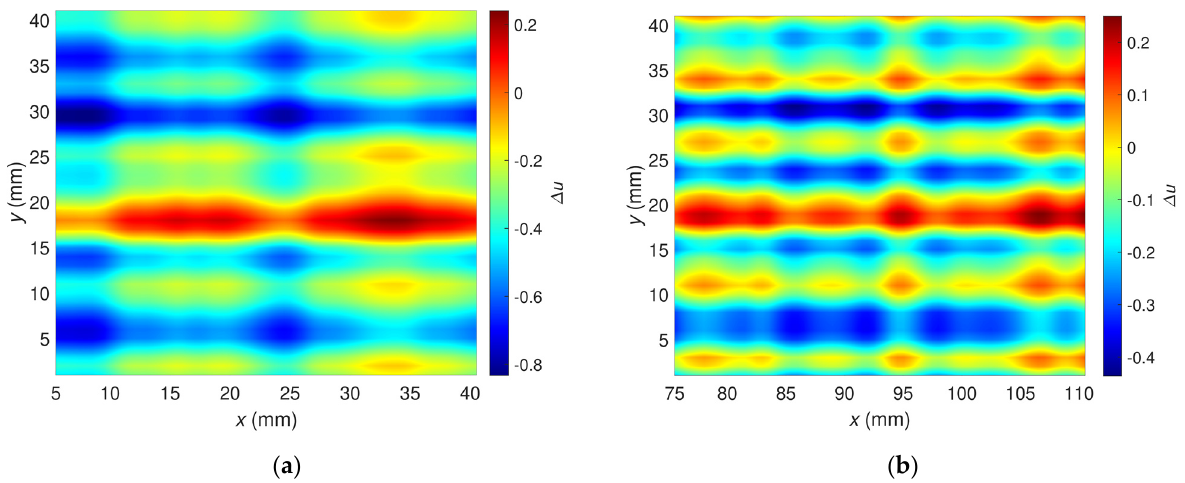
Figure 12. Two-dimensional plots of the background signals estimated for the excitation frequency f = 2 MHz, which were utilized to correct signals measured for the flaw: ( a ) OF70%, ( b ) OF30%.